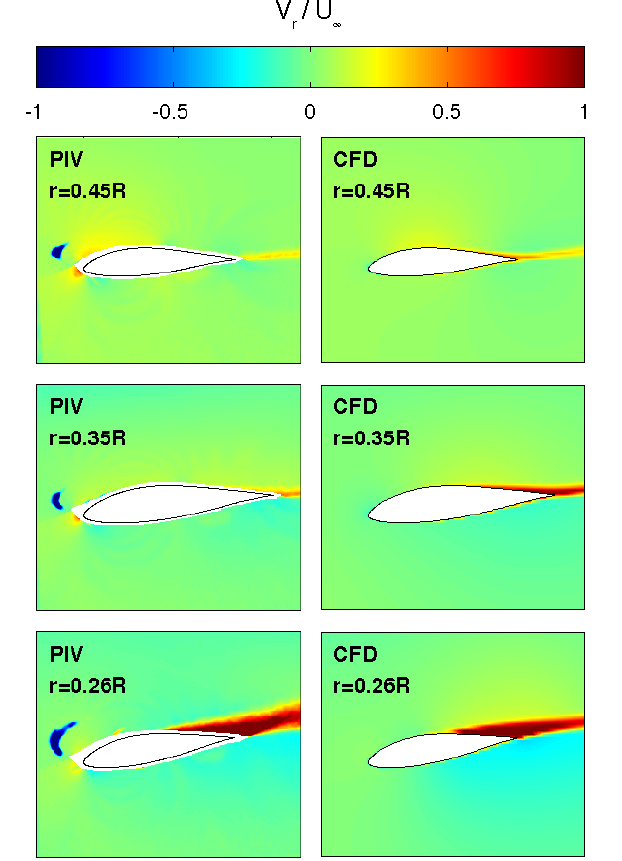
Figure 6. Experimental and numerical results of the axial velocity component at different blade spanwise positions.